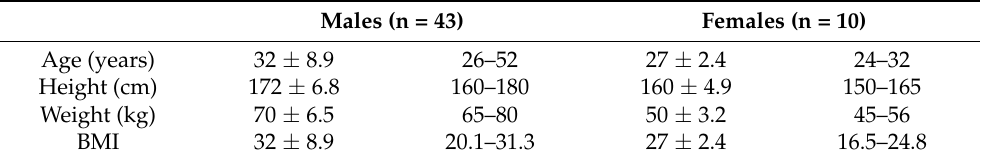
Table 1. Description of